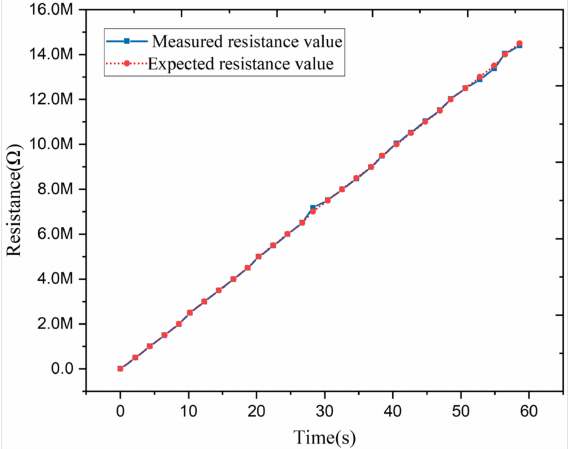
Figure 5. The synthesized resistance measurement data.